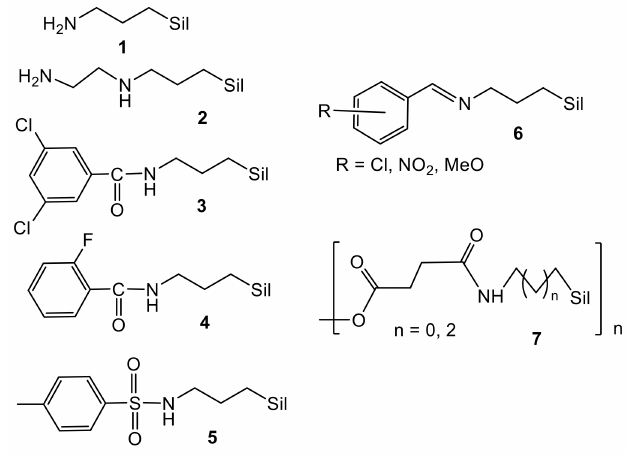
Figure 3. Chemical structures of silatranyl plant growth regulators ( 1 – 7 ).